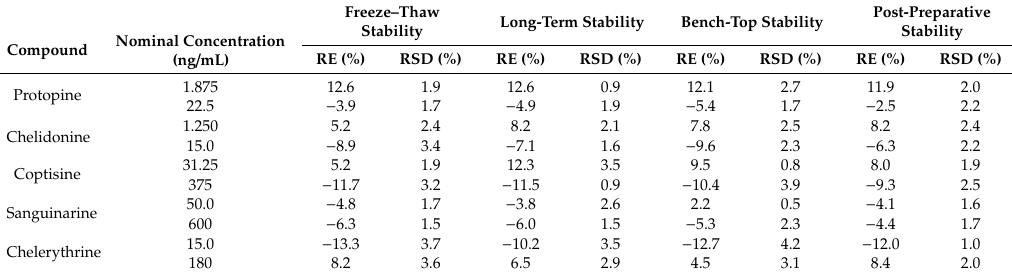
Table 4. Stability of five alkaloids under the tested